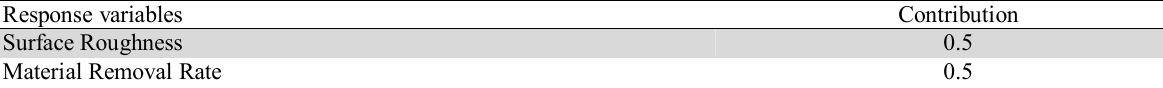
Grey Relational Grades for 18 Comparability Sequence